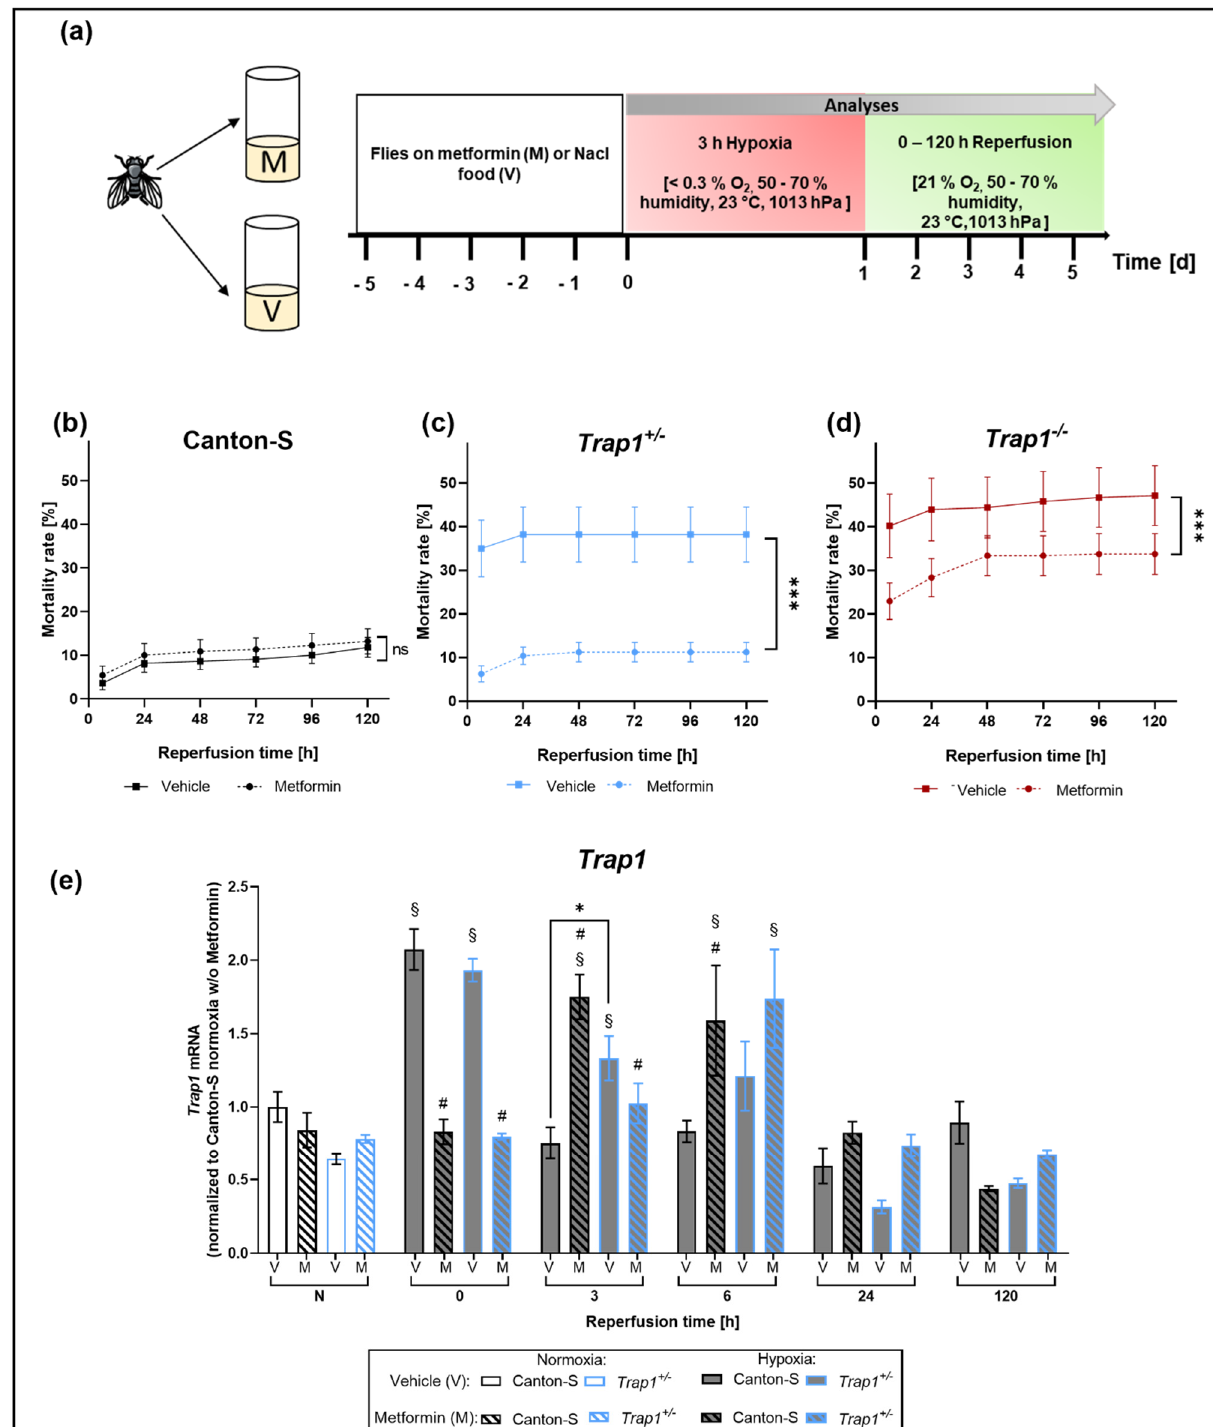
Figure 4. Hypoxia-dependent mortality and mRNA levels of Trap1 in Canton-S and Trap1 -deficient flies after Metformin treatment. ( a ) Schematic illustration of hypoxia protocol after Metformin treatment. ( b–d ) Death rates of Canton-S, Trap1 +/ − and Trap1 − / − flies after Metformin treatment and 3 h of severe hypoxia (<0.3 % O 2 ) followed by a reperfusion period of 120 h. Data are shown as means ± SEM of 4 independent experiments, including 3 technical replicates per genotype and experiment (total of 240 male flies for each genotype and condition). Welch’s t-test, two-tailed. * p < 0.05., *** p < 0.001. ( e ) Trap1 transcript levels after normoxia and hypoxia followed by different reperfusion periods are shown. The graphs present the means ± SEM of 4 independent experiments. Two-way ANOVA followed by Tukey post-hoc. * p < 0.05, *** p < 0.001. # p < 0.05 indicates significance compared to the corresponding vehicle. § p < 0.05 indicates significance compared to corresponding normoxia.